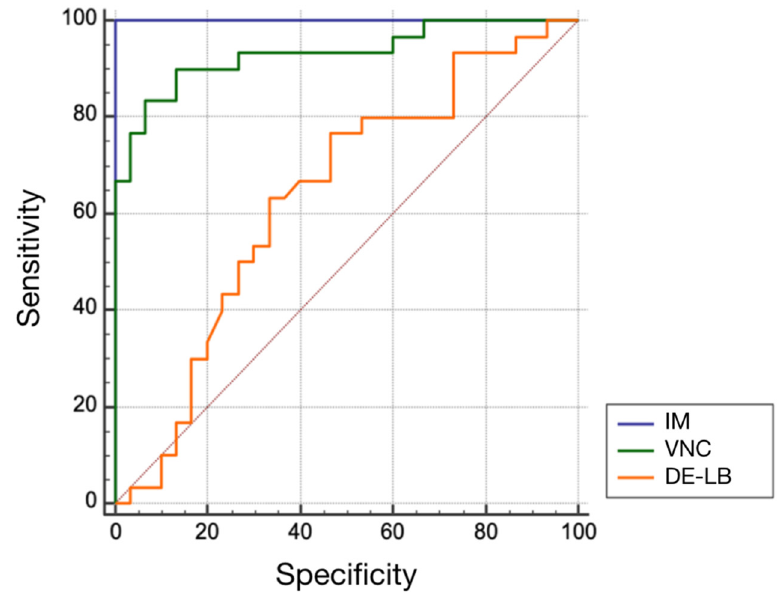
Figure 7. Comparison of ROC curves for IM, VNC, and DE-LB.